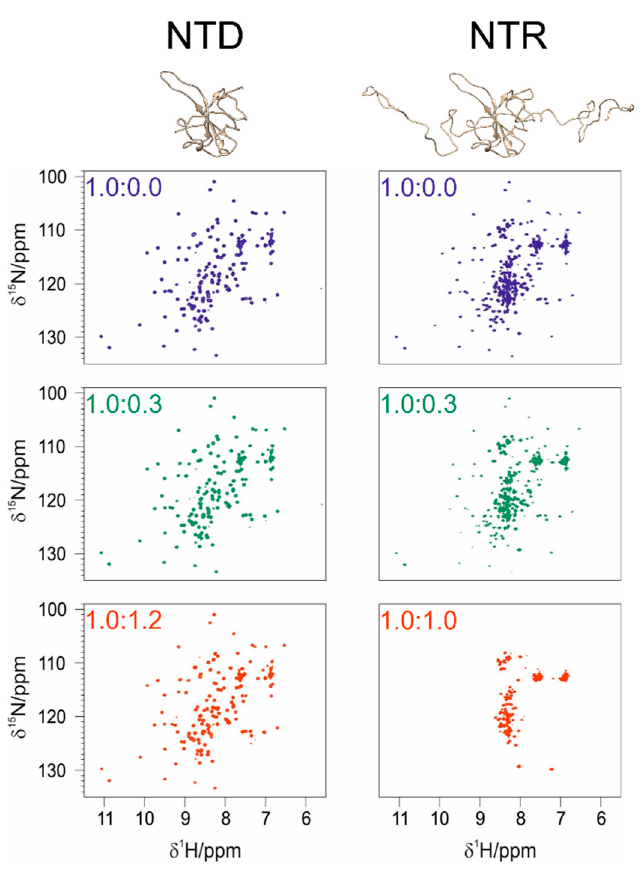
Figure 9. Comparison between the NTD and the NTR constructs at different molar ratios of protein:EP as reported in the top left corner of each spectrum.